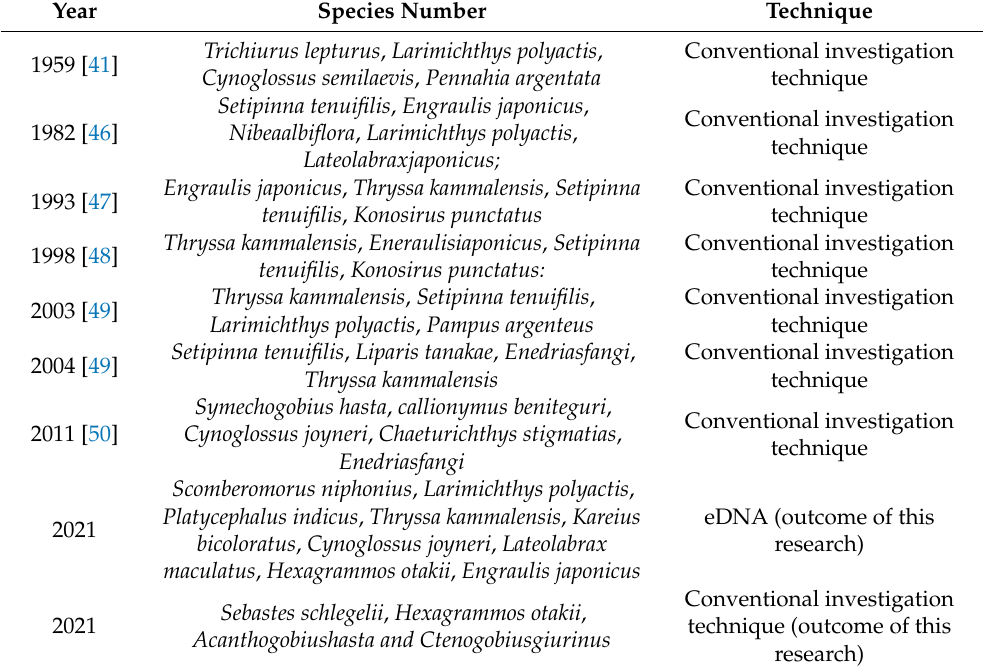
Figure 6. An inter-annual variation chart of fish communities in Laizhou Bay (The solid line represents the traditional survey method, and the dashed line represents the results of the eDNA). The sources of data are the same as in Table 6, the information for each year comes from the spring voyage in May, and the information for 2021 comes from the eDNA information of this research in spring 2021 and information from traditional survey methods). Table 6. Species composition in different years. (Both the surveys are conducted in the spring of each